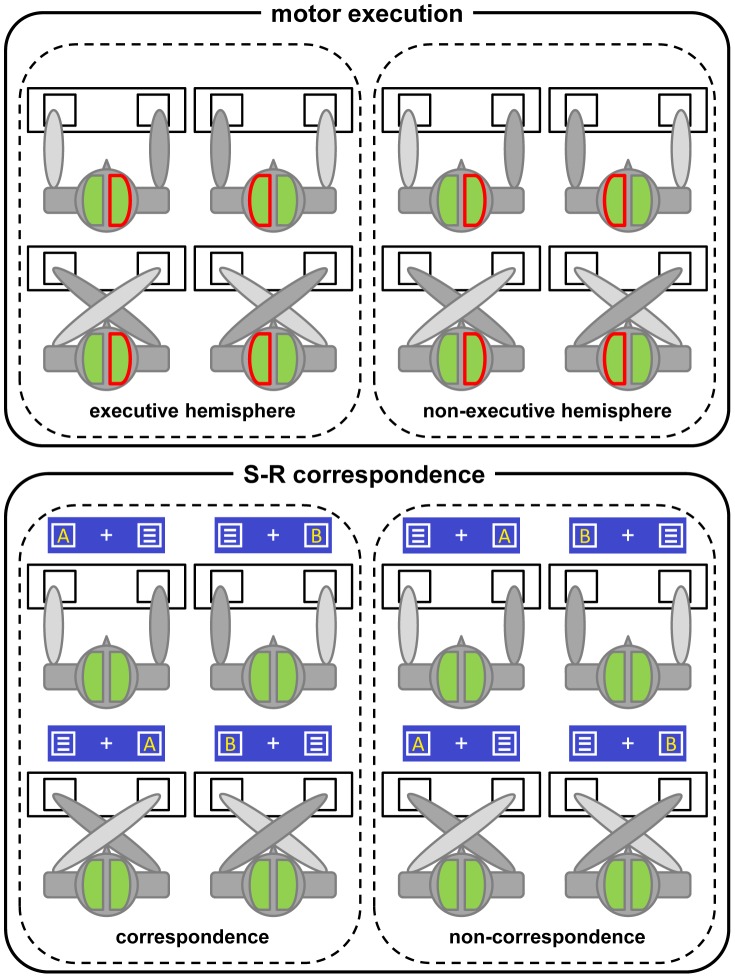
Visual illustration of experimental conditions/within-subject factors.The factor “motor execution” is depicted in the upper box. In the left section of that box, the executive hemisphere (the hemisphere responsible for the motor execution of the motor response) is marked red while in the right section of the box, non-executive hemisphere (the hemisphere not responsible for the motor execution of the motor response) is marked red. The factor “stimulus-response correspondence” is depicted in the lower box. Please note that there are parallel hands in the top rows of each of the four sub-boxes and crossed hands in the bottom rows. In a similar fashion, the left column of each of the four sub-boxes depicts left hand responses (the responding hand is indicated by light grey color), while the right column depicts right hand responses. In order to avoid explaining the obvious, we however refrained from explicitly depicting the conditions “used hand” (left anatomical hand vs. right anatomical hand) and “hand position” (parallel handy vs. crossed hands).